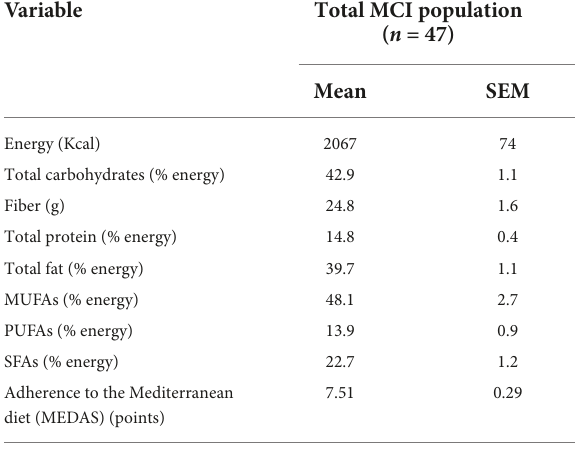
TABLE 5 Baseline anthropometric characteristics and treatment regimens of the MCI patients.